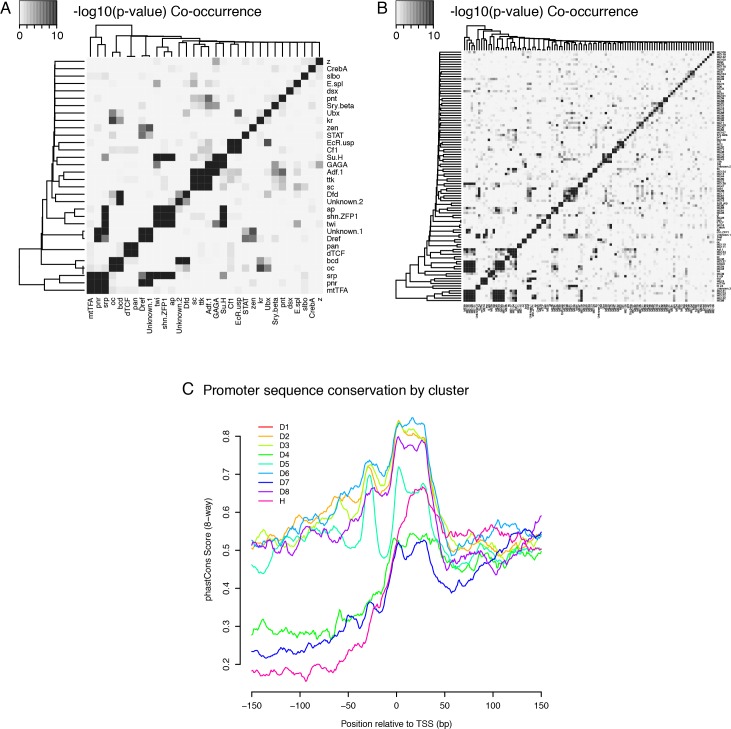
Core promoter types: Co-occurence of TFBSs and Sequence conservation profiles.(A) Co-occurence of TFBSs within the same promoter regions (top three motifs for each of the nine expression clusters) (B) Co-occurence of TFBSs within the same promoter regions (top 10 motifs for each cluster) (C) Median sequence conservation profiles of the promoter regions of the nine clusters (8-way phastCons scores).